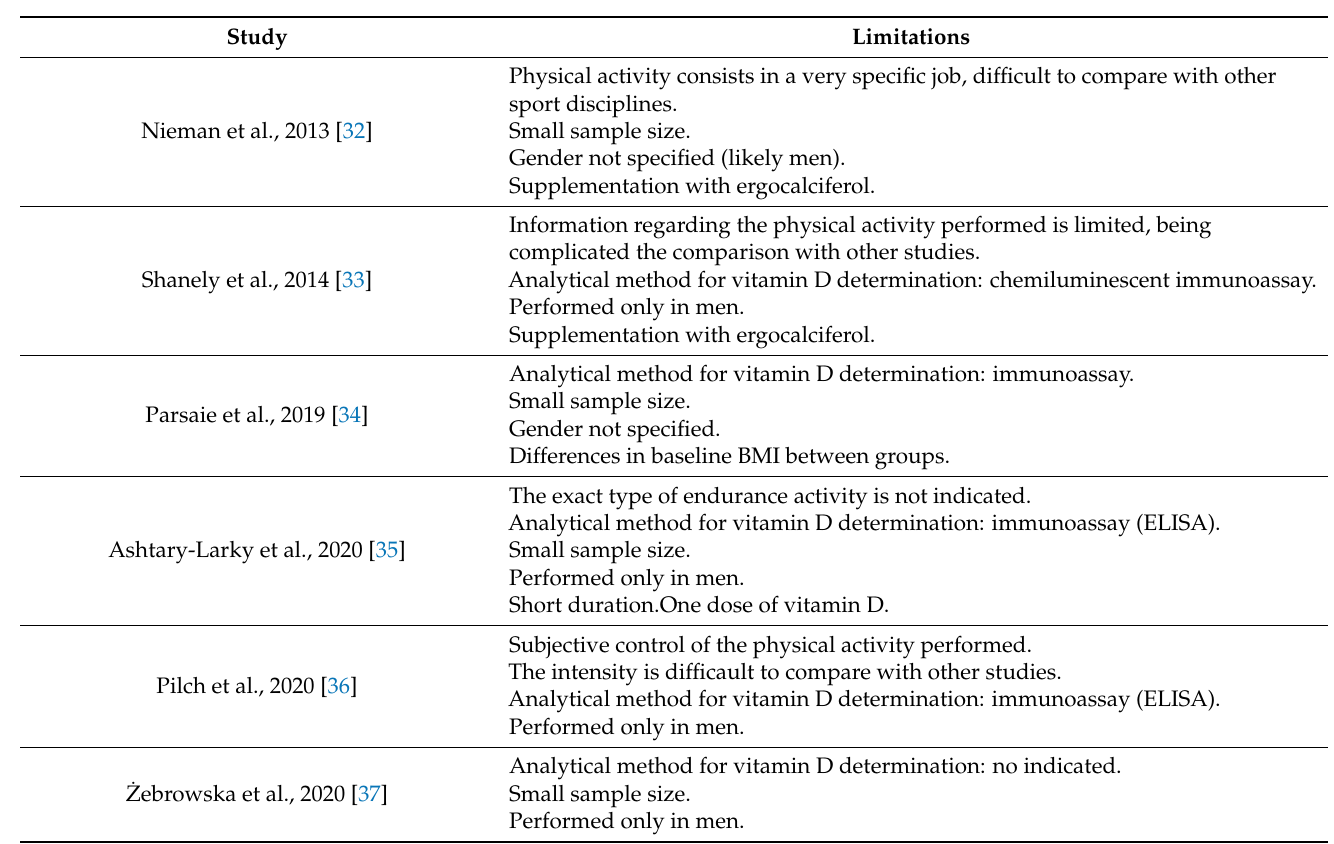
Table 5. The main limitations of the different studies of the